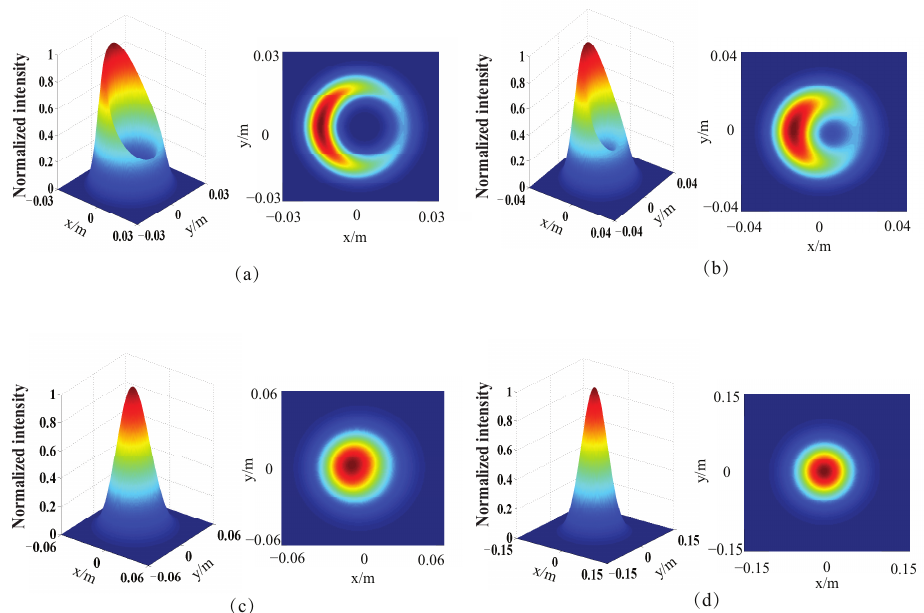
Figure 2. Normalized average intensity and corresponding contour graphs of the OAHGSM vor- tex beam propagating through anisotropic oceanic turbulence. ( a ) z = 100 m, ( b ) z = 300 m, ( c ) z = 600 m, ( d ) z = 1200